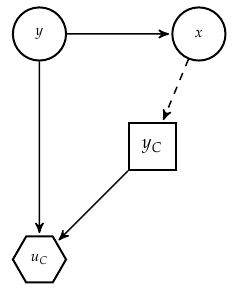
Figure 1. Classification as an Influence Diagram